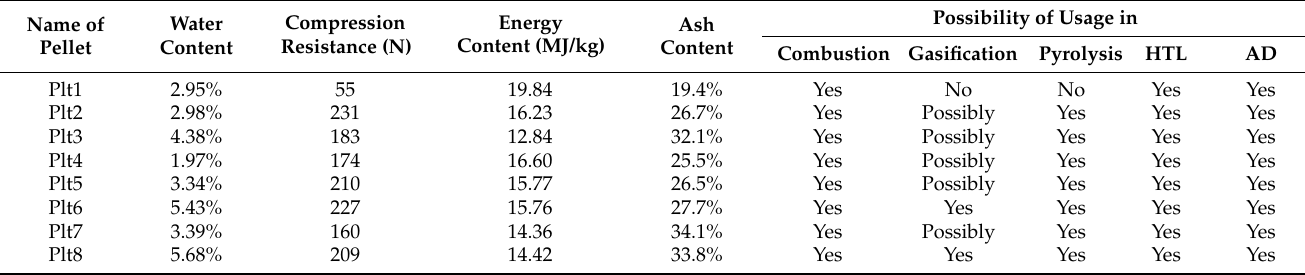
Table 3. Comparison of the ash content, water content, compression resistance, energy content, and usage potential of different seaweed